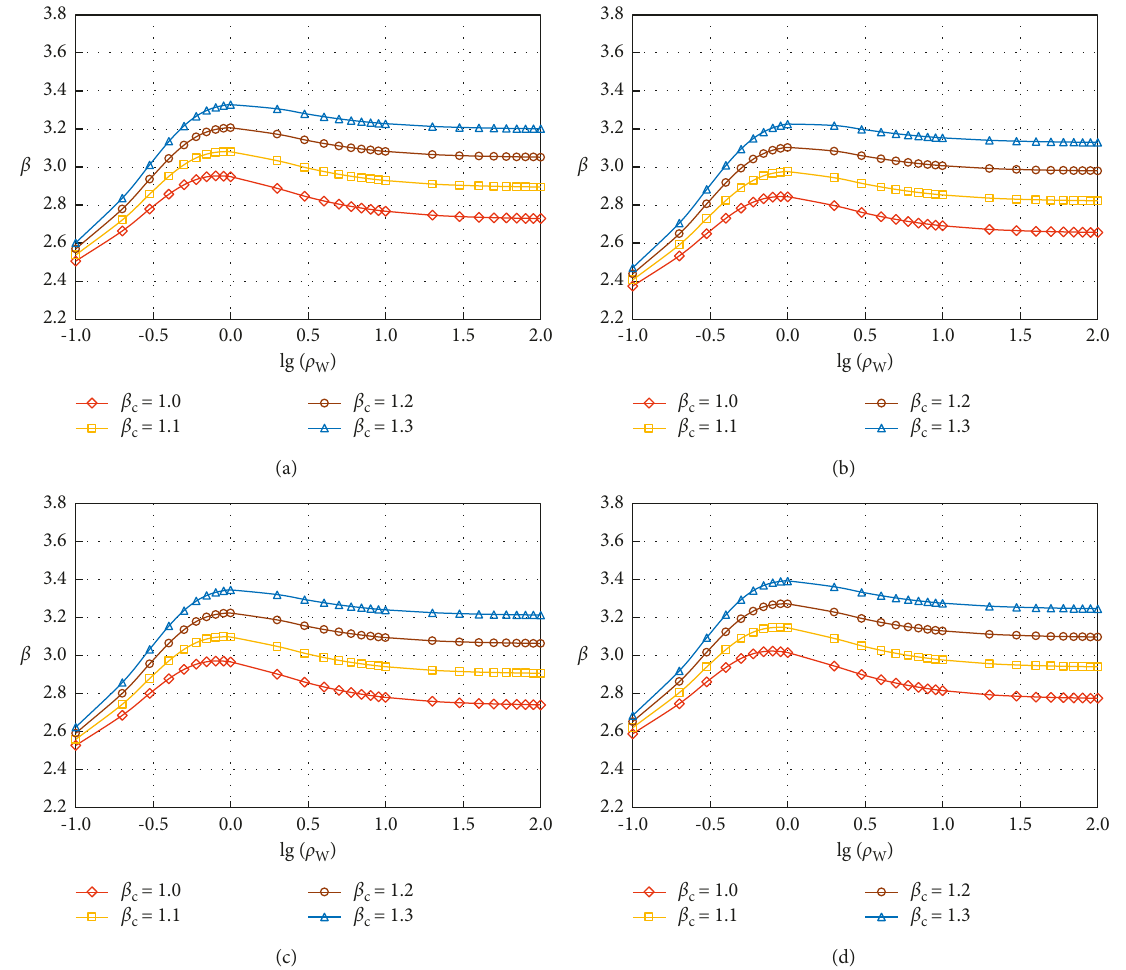
Figure 3: Reliability indices for stability calculation of axially loaded member. (a) Q235: d > 16 ∼ 40mm, (b) Q235: d > 40 ∼ 60 mm, (c) Q345: d > 16 ∼ 35 mm, and (d) Q345: d > 35 ∼ 50 mm.